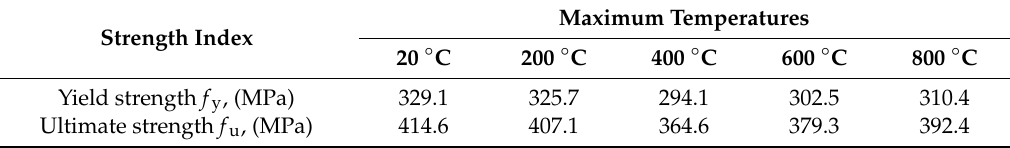
( e ) 800 °C Figure 9. Failure pattern of the loading end after push-out test.